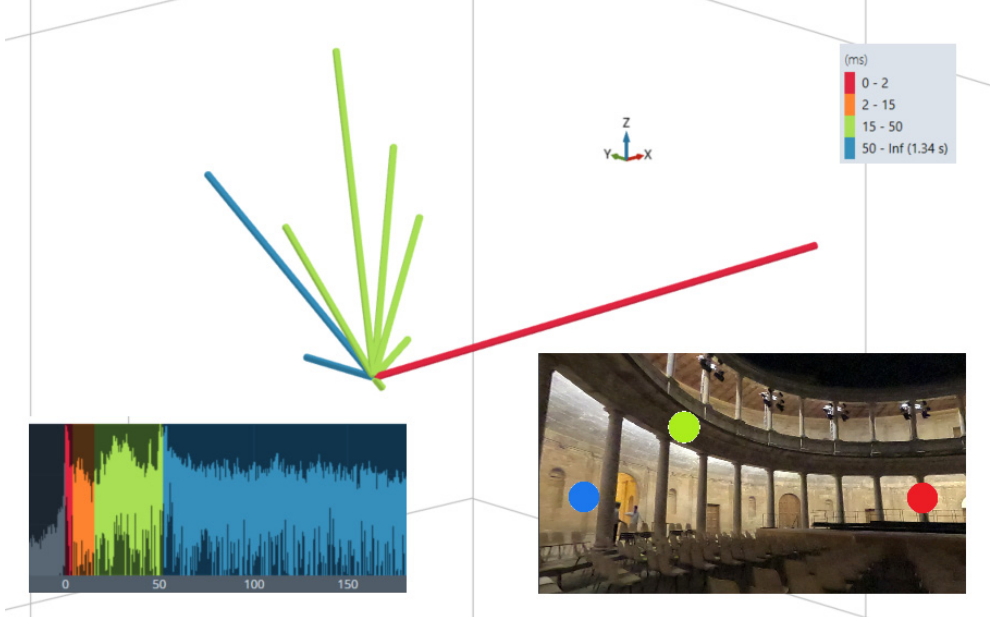
Figure 15. Directions of arrival of reflections. Time regions and 360 ° photograph included. 10 dB range.